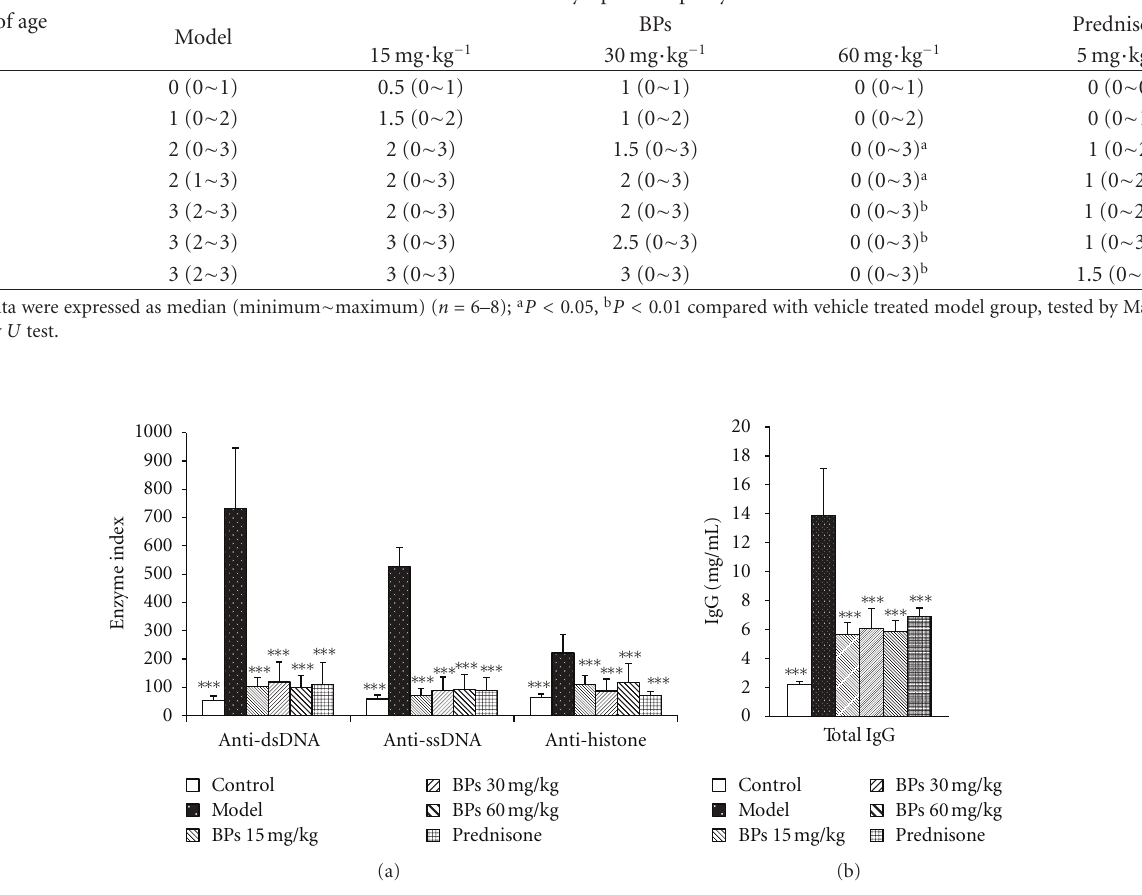
Figure 3: E ff ect of BPs on antinuclear antibodies and total IgG production in BALB/c and MRL-lpr mice. MRL-lpr mice were grouped randomly and treated with BPs 15, 30, and 60mg · kg − 1 · day − 1 , prednisone 5mg · kg − 1 · day − 1 , or model from week 12 to week 24; data were expressed as means ± SD ( n = 6–8); ∗∗∗ P < 0 . 001 compared with vehicle-treated model group, tested by ANOVA and Fisher’s PLSD. Enzyme Index = 100 × OD tested / (MeanOD controlgroup +